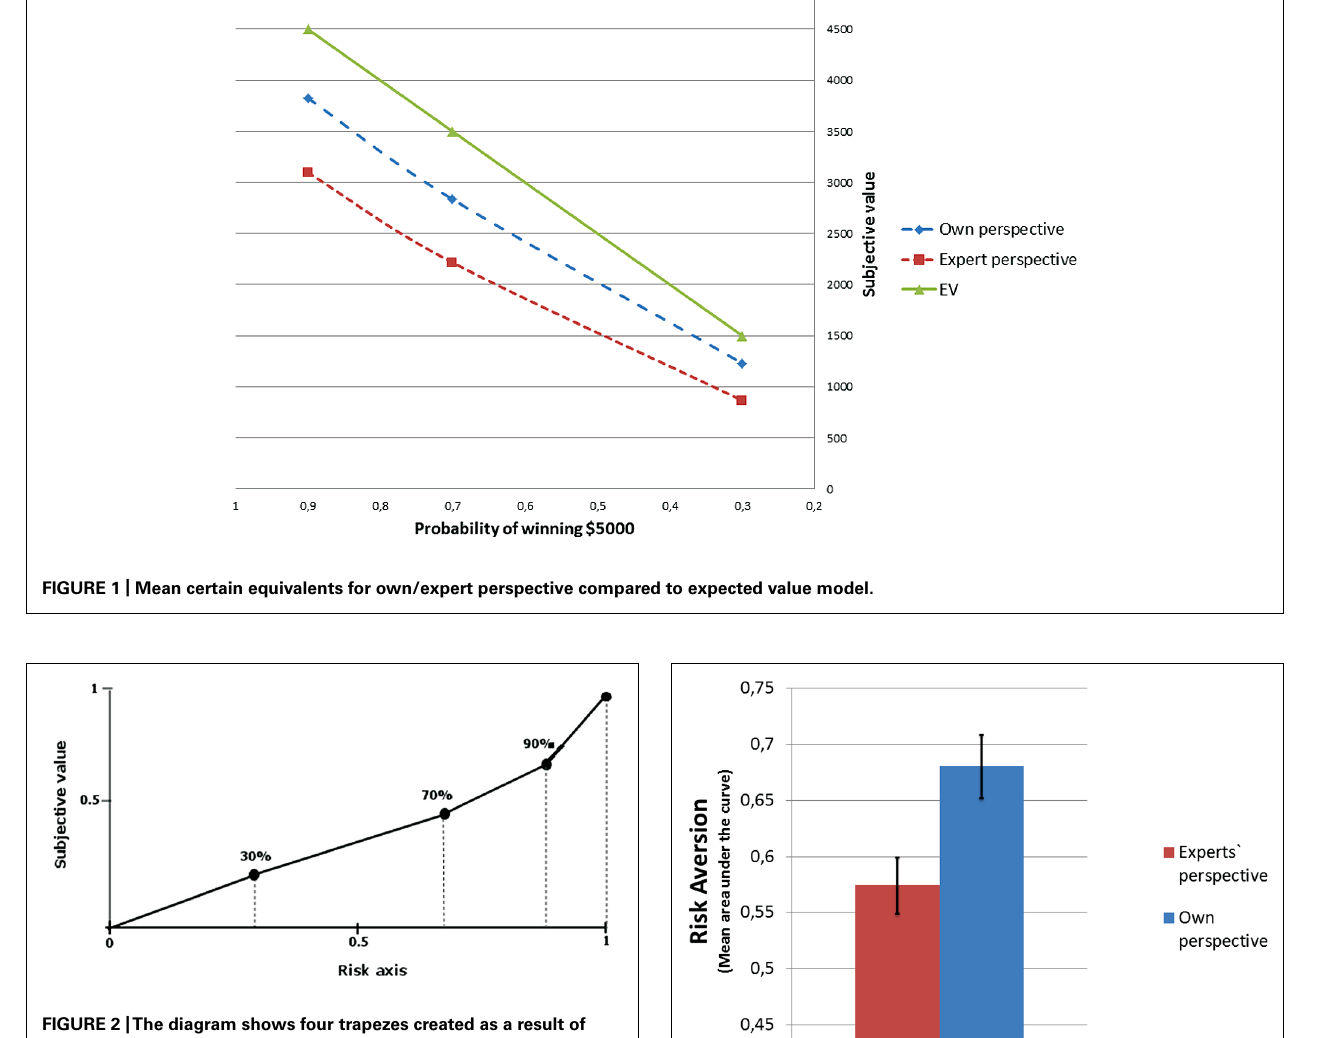
FIGURE 2 |The diagram shows four trapezes created as a result of connecting equivalent points, with the risk axis by line segments. Both the risk and subjective value of the sum are standardized from the range from 0 to 1.Value 1 on the risk axis corresponds to a certain value, and on the subjective value axis the non-discounted sum. Own elaboration based on: Myerson etal. (2001). FIGURE 3 | Mean area under the curve for uncertain